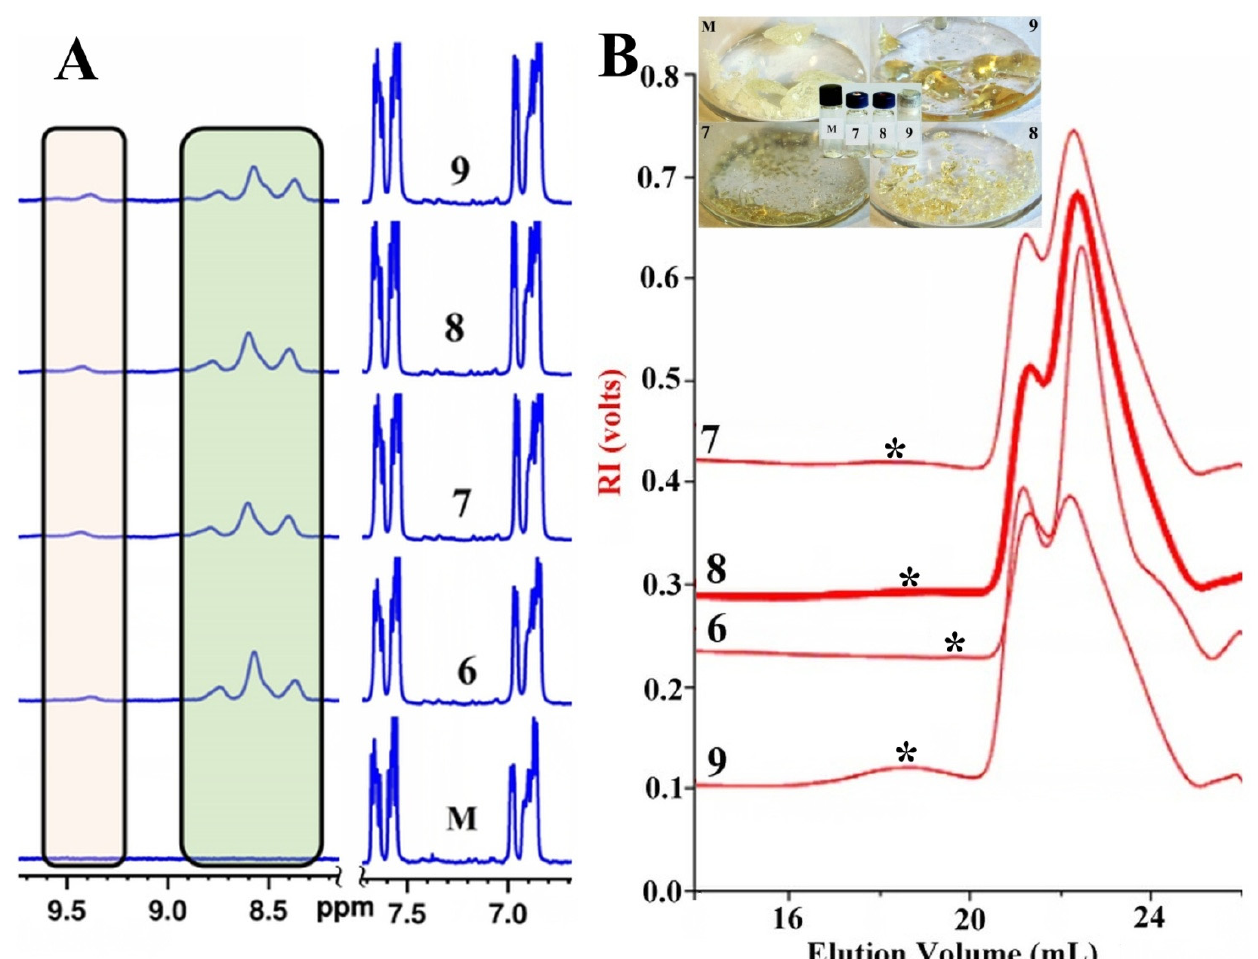
Figure 7. ( A ) 1 H-NMR spectra in DMSO-d 6 (the aromatic region) of macromonomer Th-MeOx ( M ) and of the resulting mixtures after SAAP in 2, 4 and 6 hours of incubation at 150 °C (open and closed vials); ( B ) GPC traces in Chl of the mixtures resulting after SAAP of macromonomer Th-MeOx : M -macromonomer; 7 : 4 h in open vial; 8 : 4 h in closed vial; 9 : 6 h in open vial; in the inset are photos of the samples in solid state after SAAP.